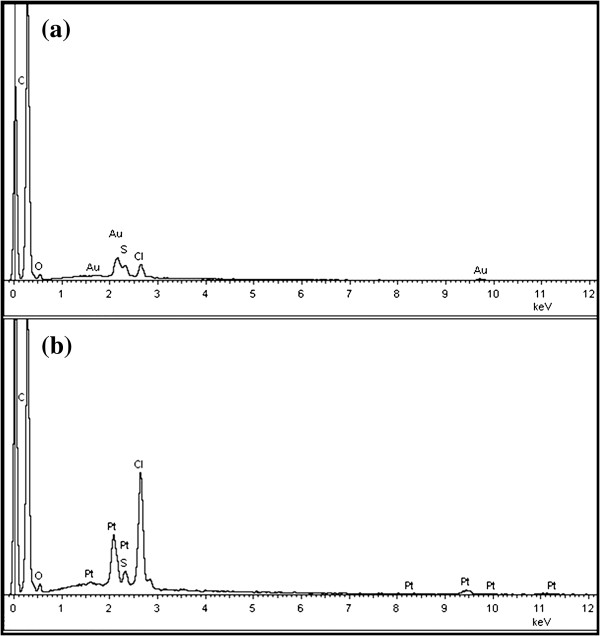
EDS spectra of composites. (a) PANI(HAuCl4·4H2O) and (b) PANI(H2PtCl6·6H2O).